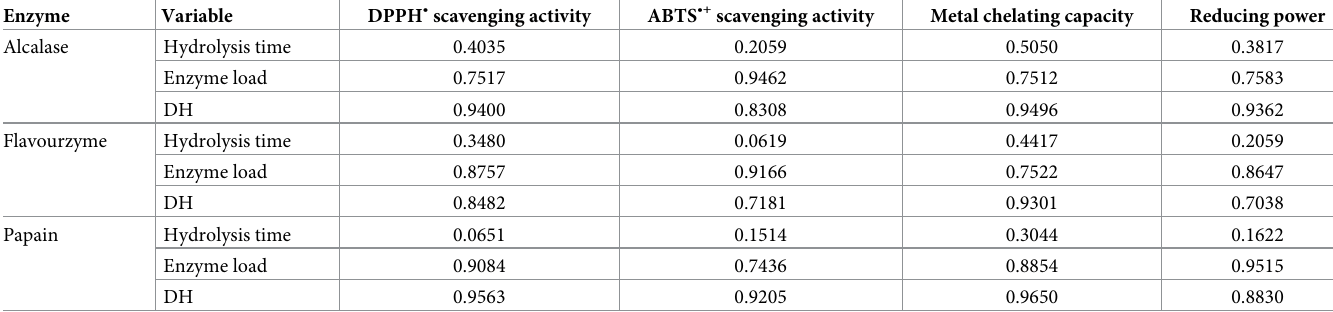
Table 2. Correlation coefficient of enzymatic hydrolytic variables and antioxidant activities of porcine placenta hydrolysate.